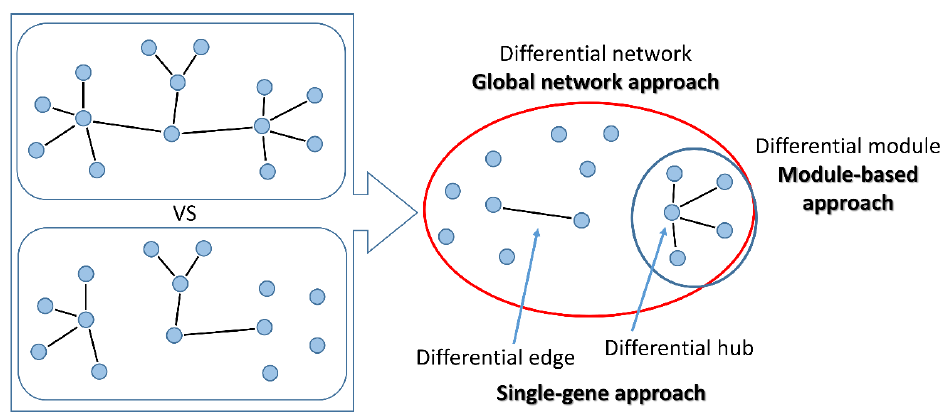
Figure 3. Methods for di ff erential co-expression. Left: two conditions are compared. Right: with “global network” approaches, the overall di ff erential network is built; “module-based” methods identify groups of di ff erentially connected nodes; the “single-gene” approach searches for pairs of genes changing connections (di ff erential edges) or single genes changing connectivity within the network (di ff erential hubs). Table 5. Methods integrating co-expression and other sources of information.